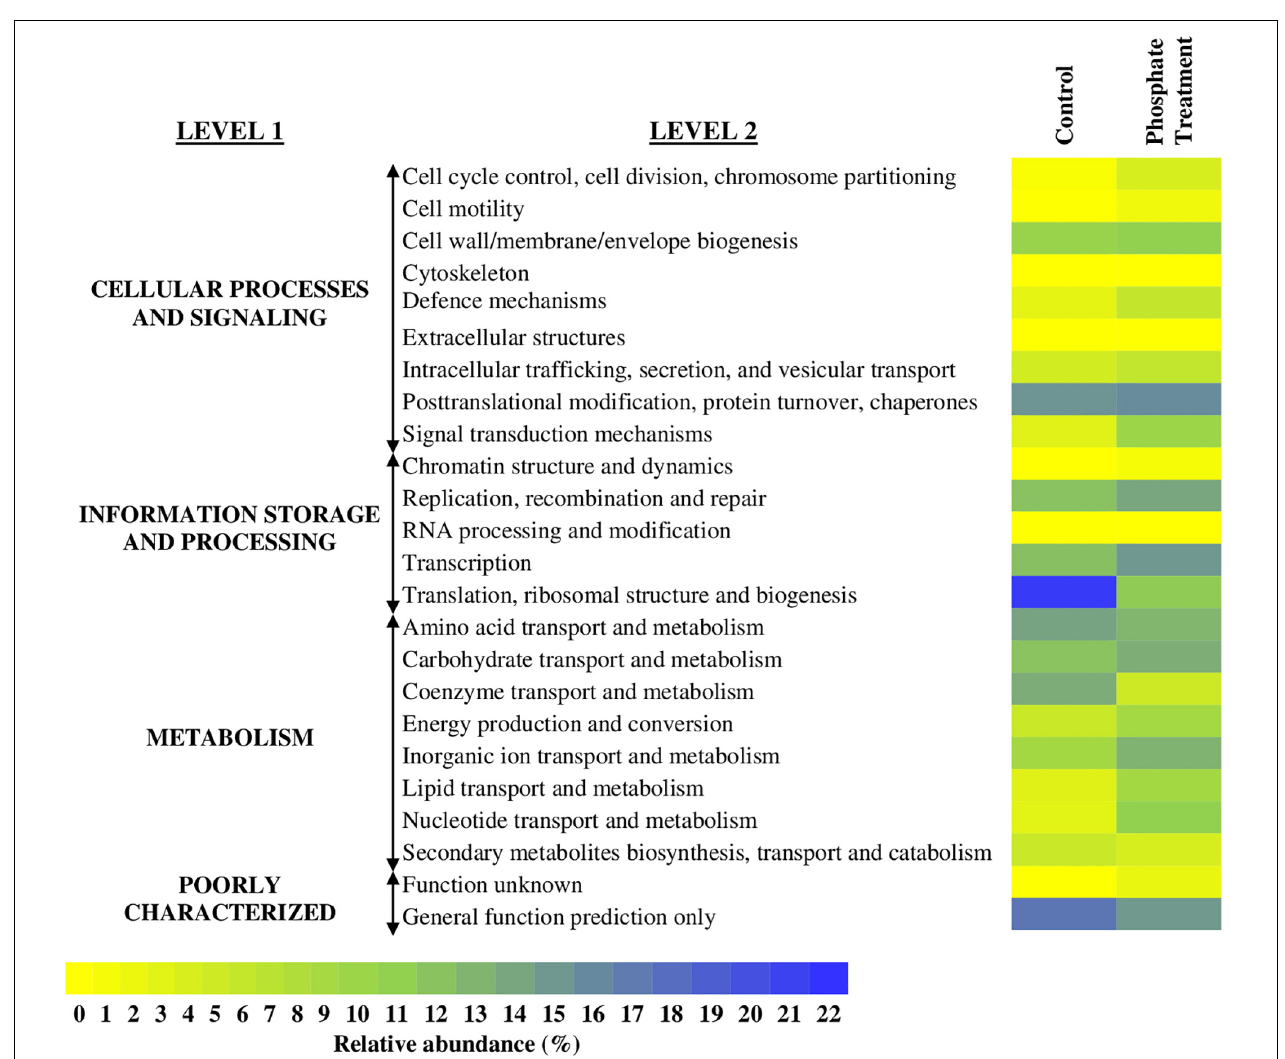
FIGURE 7 | Heatmap with the relative abundance of annotated genes in the whole metagenome of each of the sequenced samples. It is shown MG-RAST analyses of biofilm samples based in COGs database. The average of relative abundance ( n = 3) of the level 1 and 2 functional categories is expressed in a rage of colour from yellow (0%) to blue